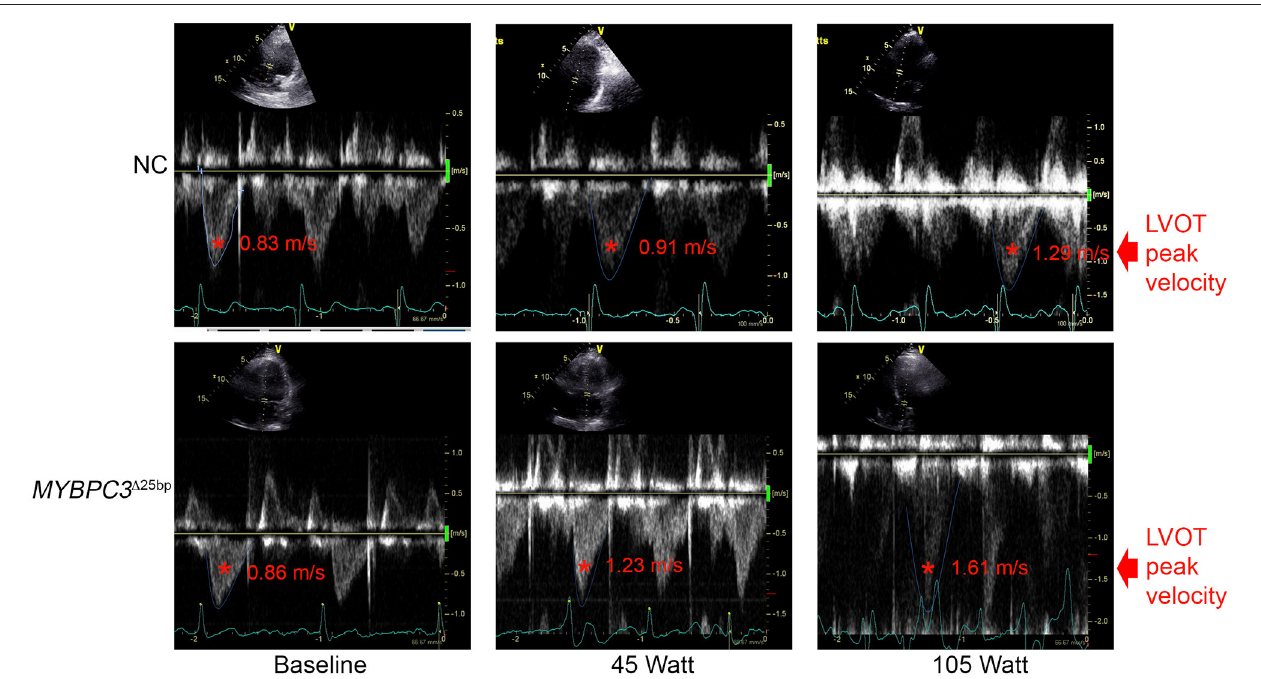
FIGURE 3 | Spectral Doppler data depict LVOT peak velocity. Representative apical five-chamber view at baseline, 45 (W), and 105 (W) in a NC (upper panel) subject and a MYBPC3 1 25bp variant carrier (lower panel). NC,